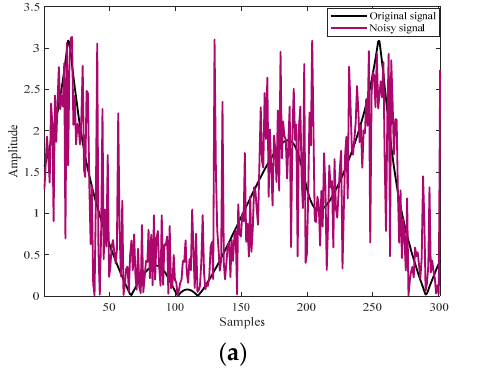
Figure 4. Signal reconstruction performance of different algorithms with an SNR of 10 dB. ( a ) Original signal phase and noise, ( b ) reconstruction results of signal phase by different algorithms.